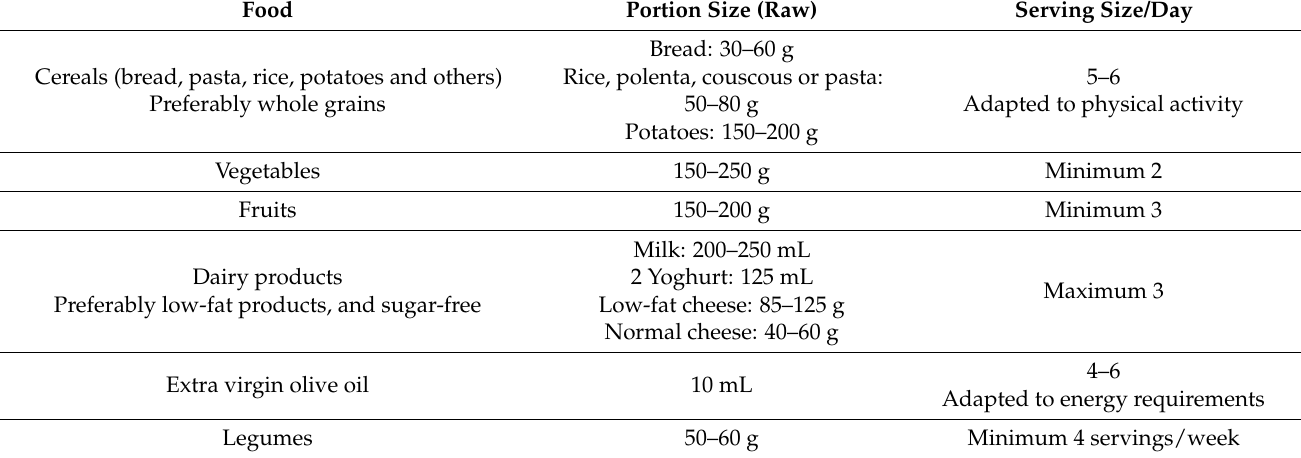
Table 1. Recommendations of the frequency of food adapted to Mediterranean diet (MD)